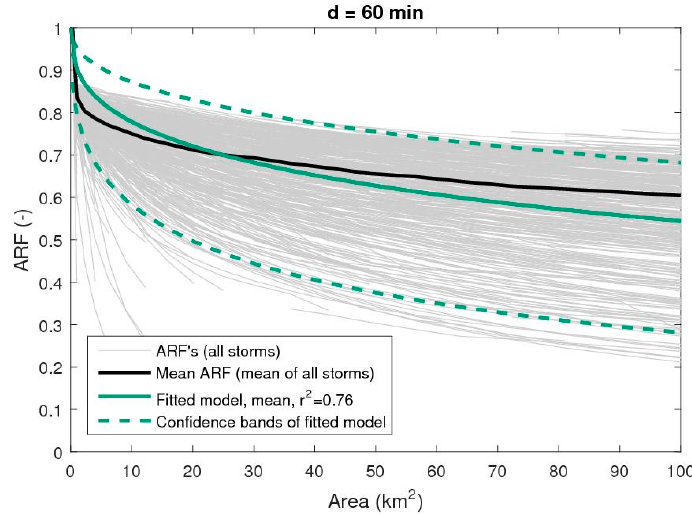
Figure 4. Aerial reduction factors ( ARF) for durations of 60 min. Dashed lines are the confidence limits Figure 4. Areal reduction factors ( ARF ) for durations of 60 min. Dashed lines are the confidence limits (mean +/ − std. dev.) of the fitted ARF . (mean +/ − std. dev.) of the fitted ARF